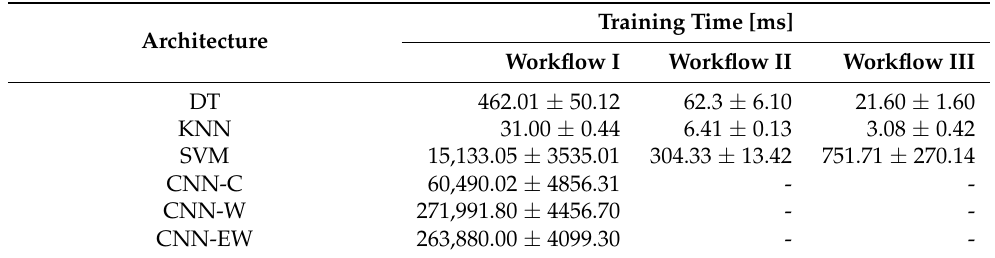
Table 4. Average and standard deviation training time measured in milliseconds taken by classifiers and respective workflows to shape decision function in five-fold learning